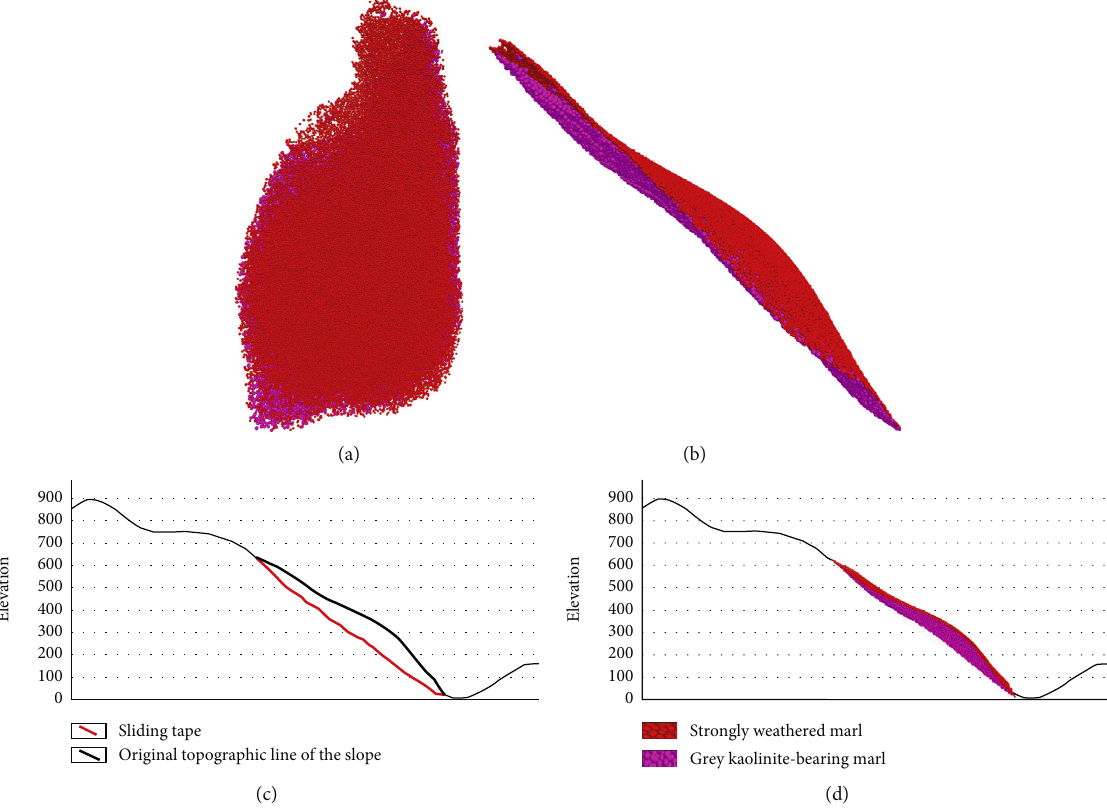
Figure 4: Slip morphology diagram and comparison of model sections. (a) Front view of slip form. (b) Side view of slip form. (c) Presumed -A pro fi le of the landslide. (d) Numerical model A preslip and postslip A 1 1